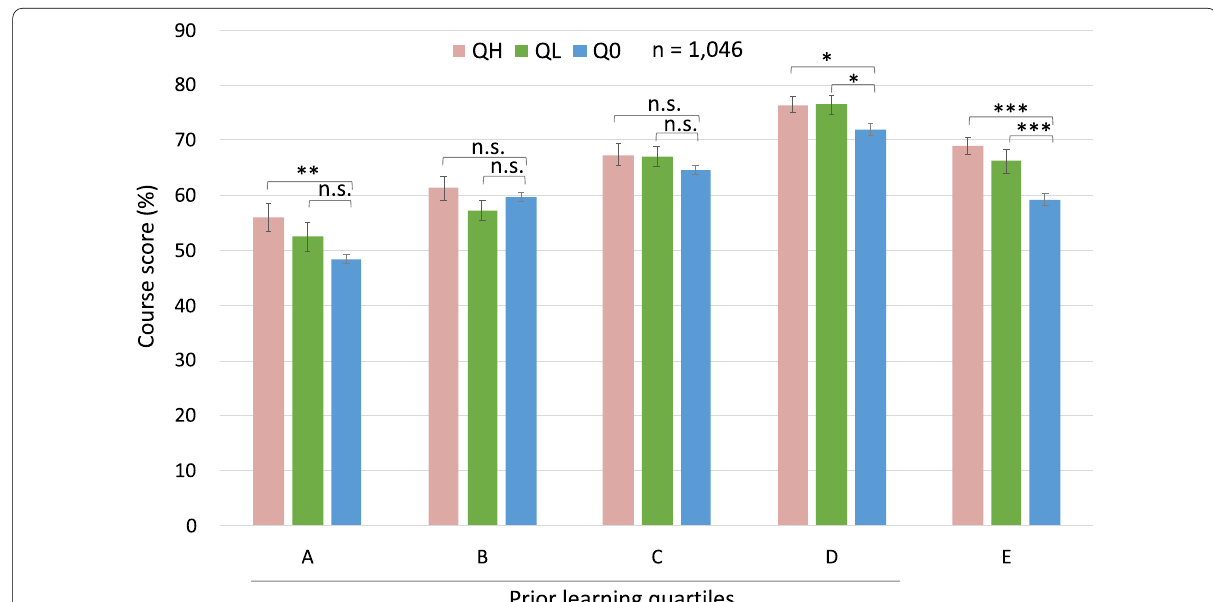
Fig. 4 The effect of quecture engagement on course score for different prior performance cohorts. Least squares means and standard errors (corrected for between-year and sample size differences) are plotted for each cohort quecture combination from the 2017, 2018 and 2019 iterations of the course combined. Quartiles A–D were of equal size within each year (50 students in 2017, 83 or 84 students in 2018 and 79 or 80 students in 2019) while group E contained 65 students from 2017 and 2019, and 67 students from 2018. QH high quecture engagers, QL low quecture engagers, Q0 students that did not engage with quectures. Whilst overall quecture engagers (QH and QL) have higher scores than Q0 (P < 0.0005), the benefits of quecture engagement varied among cohorts (P 0.0198) with most benefit for cohorts A, D and E . * p < 0.05 **, p < 0.01, *** = p < 0.005, n.s. not =